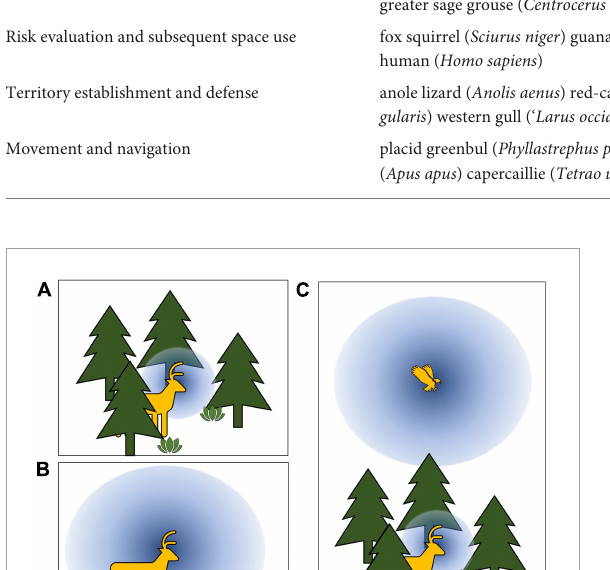
FIGURE1 Conceptual representation of hypothesized relationships between visibility (blue spheres) and habitat structure and perspective. (A,B) Ecosystems with extensive vegetation structure (e.g., forests) will afford smaller viewsheds relative to ecosystems with little structure (e.g., prairies). (C) Animal position within habitat structure will influence viewsheds, with visibility generally increasing with eye-height above the